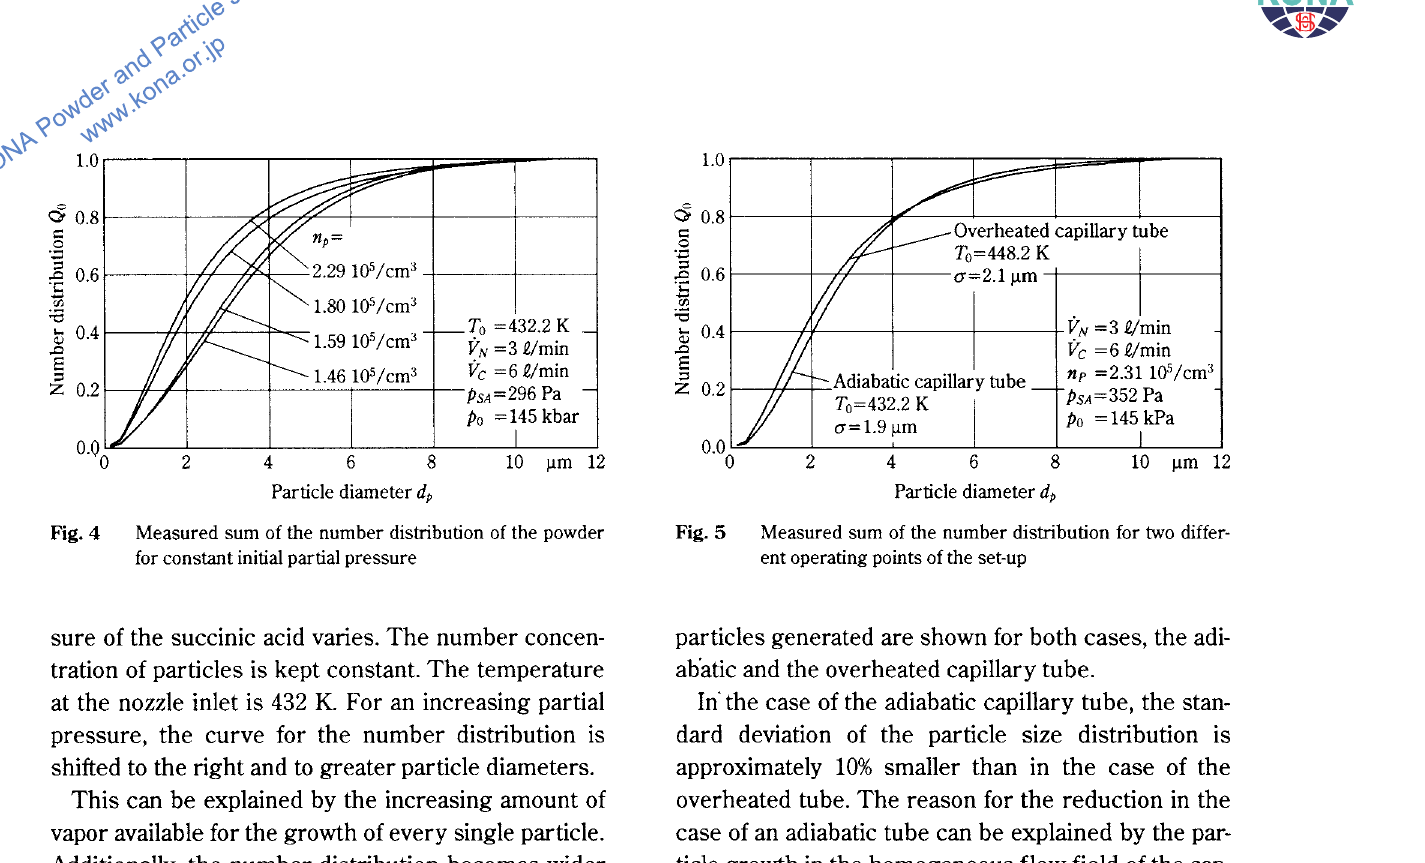
Measured sum of the number distribution for two differ ent operating points of the set-up